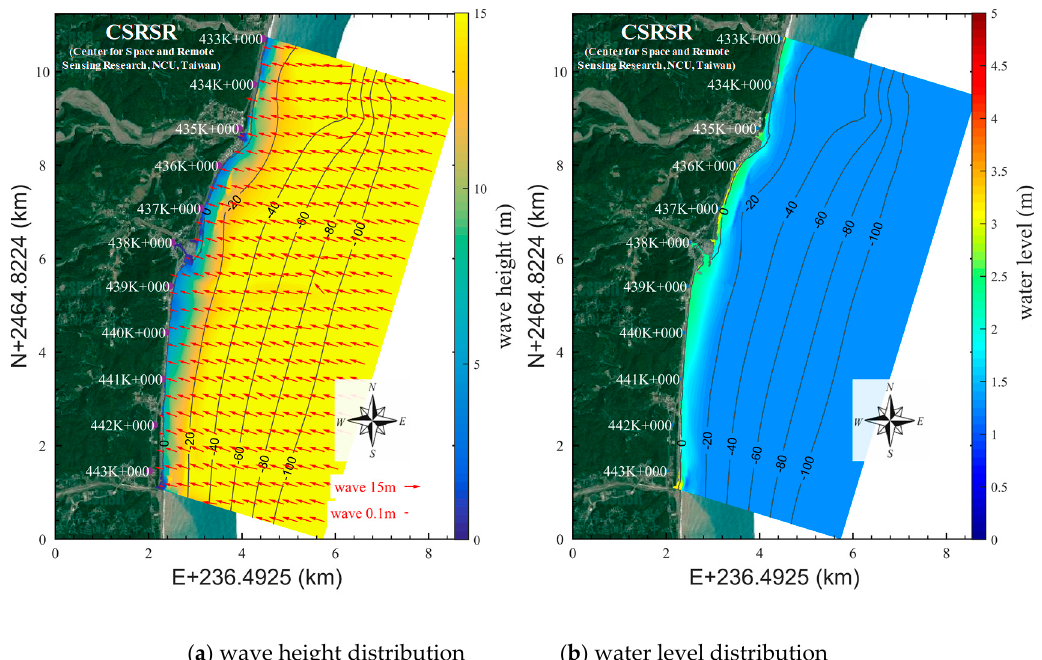
Figure 19. Wave field and water level distribution in Region A.